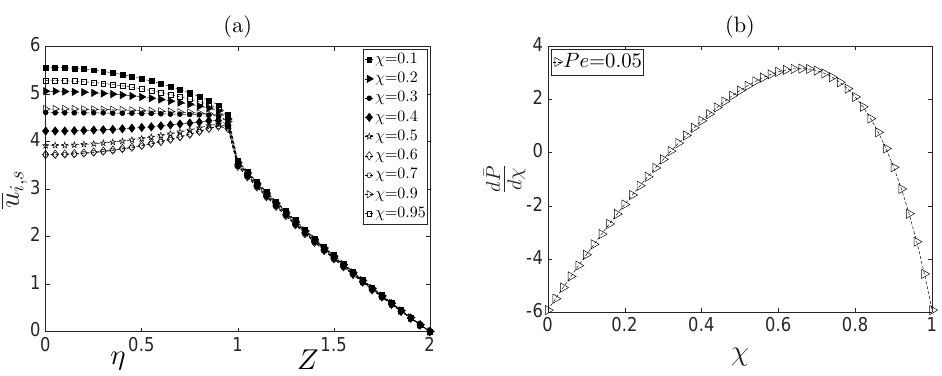
Figure 3. ( a ) Dimensionless velocity profiles, evaluated at different values of the coordinate χ , and ( b ) the corresponding pressure gradient along the